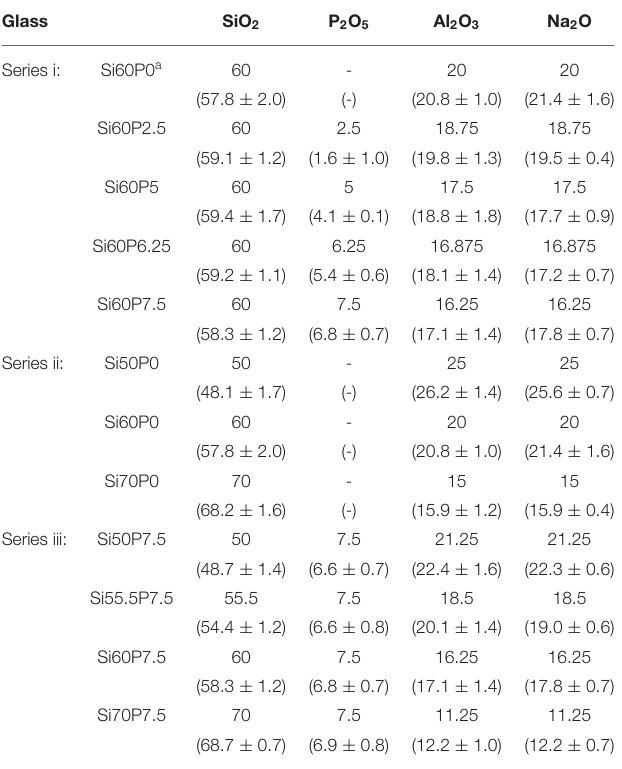
TABLE 1 | Nominal and (in brackets) analyzed glass compositions